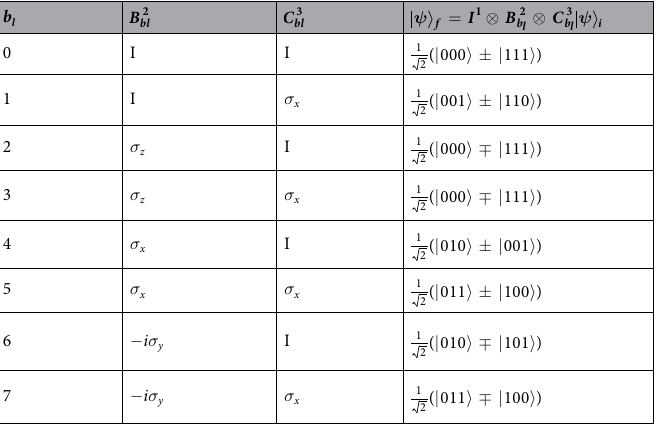
1 (|000 〉 ± |111 〉 which is i 2 if σ x , σ y and σ z are Pauli f